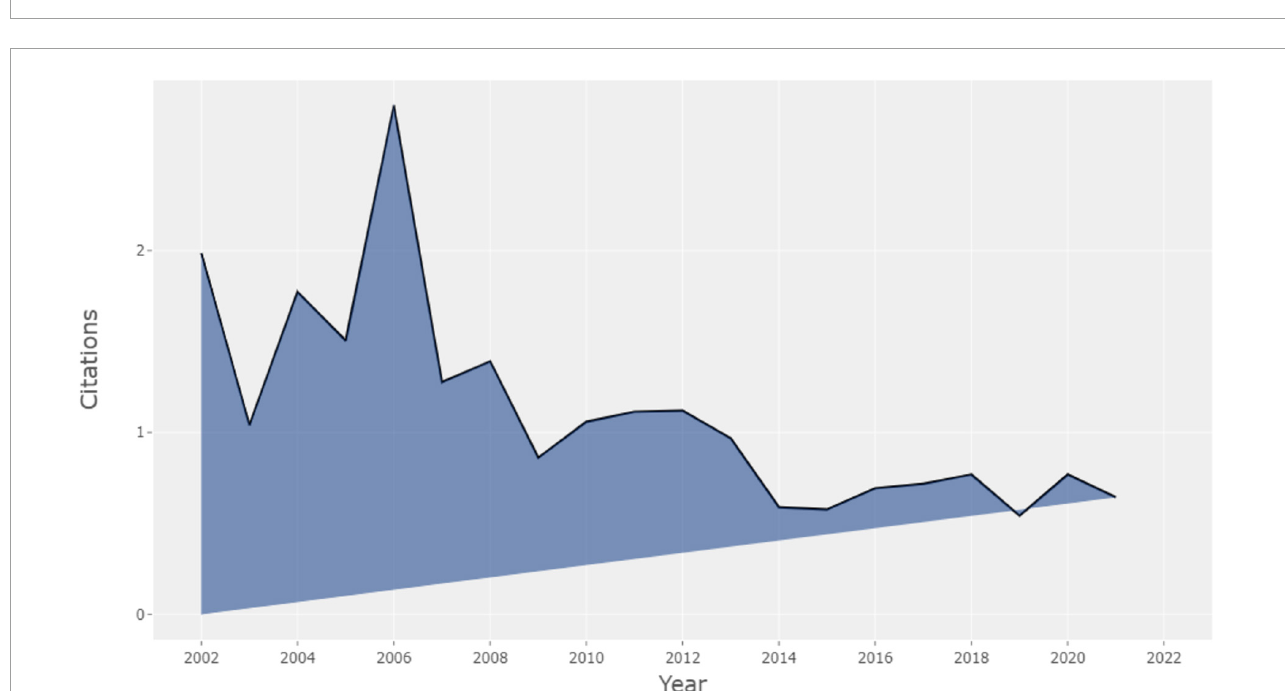
FIGURE1 Annual scientific production.